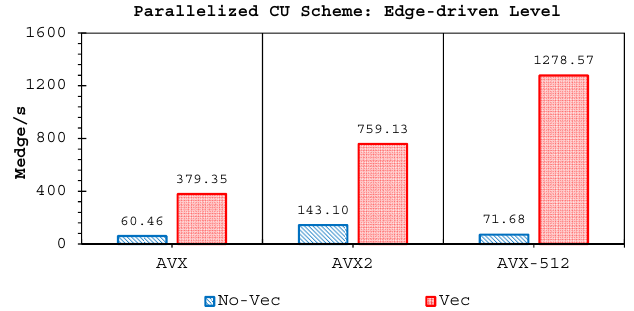
Figure 19. Single-node performance of the non-vectorized and vectorized CU scheme with parallelization (edge-driven